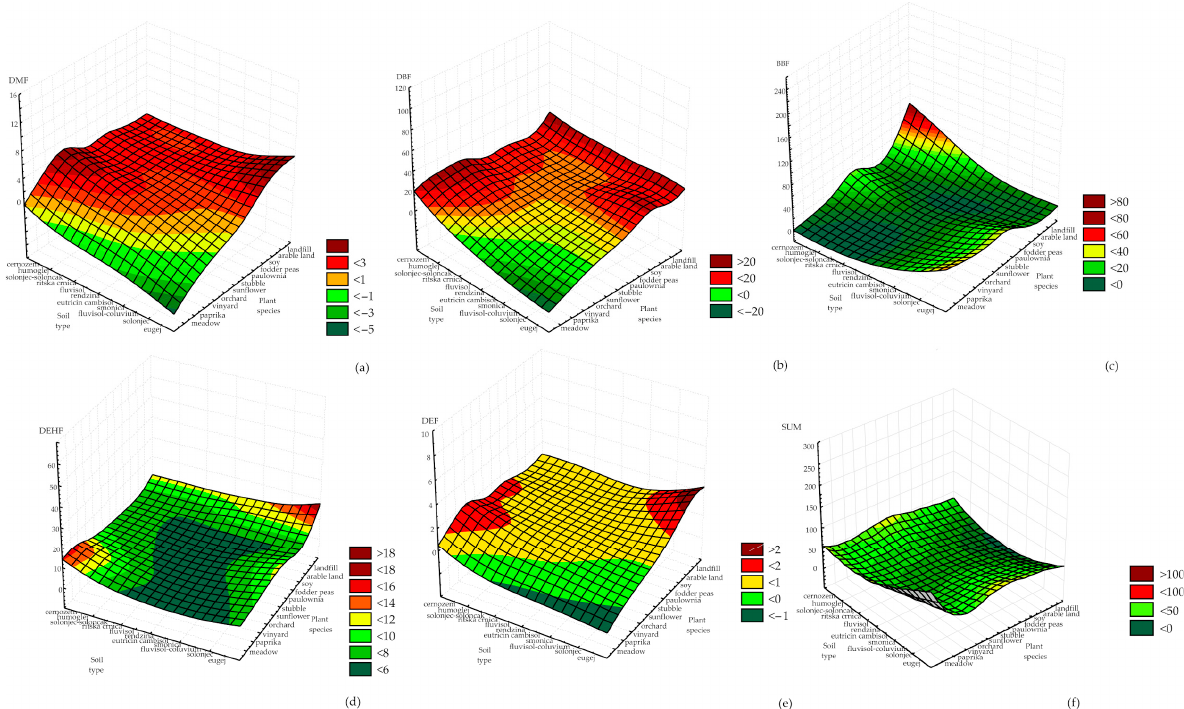
Figure 6. Influence of input variables on PAE concentrations: ( a ) DMF, ( b ) DBF, ( c ) BBF, ( d ) DEHF, ( e ) DEF and ( f ) SUM.